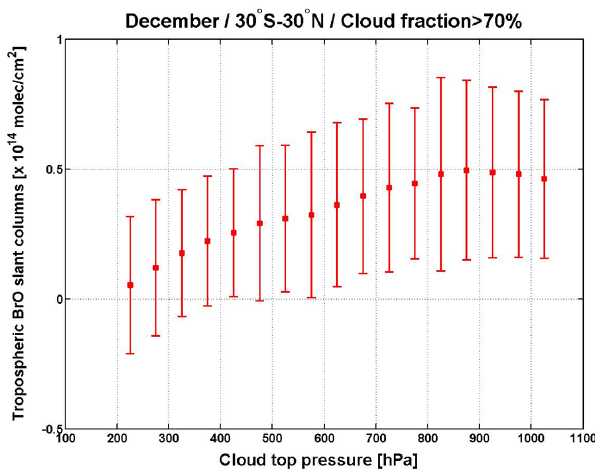
Fig. 15. GOME-2 tropospheric BrO slant columns as a function of cloud top pressure (cloud fraction > 70%), in December for − 30 ◦ ≤ latitude ≤ 30 ◦ . The red squares correspond to the mean tropo- spheric BrO SCD values for cloud top pressure bins of 50hPa, and the error bars represent the variability of the column within each bin (1 σ)